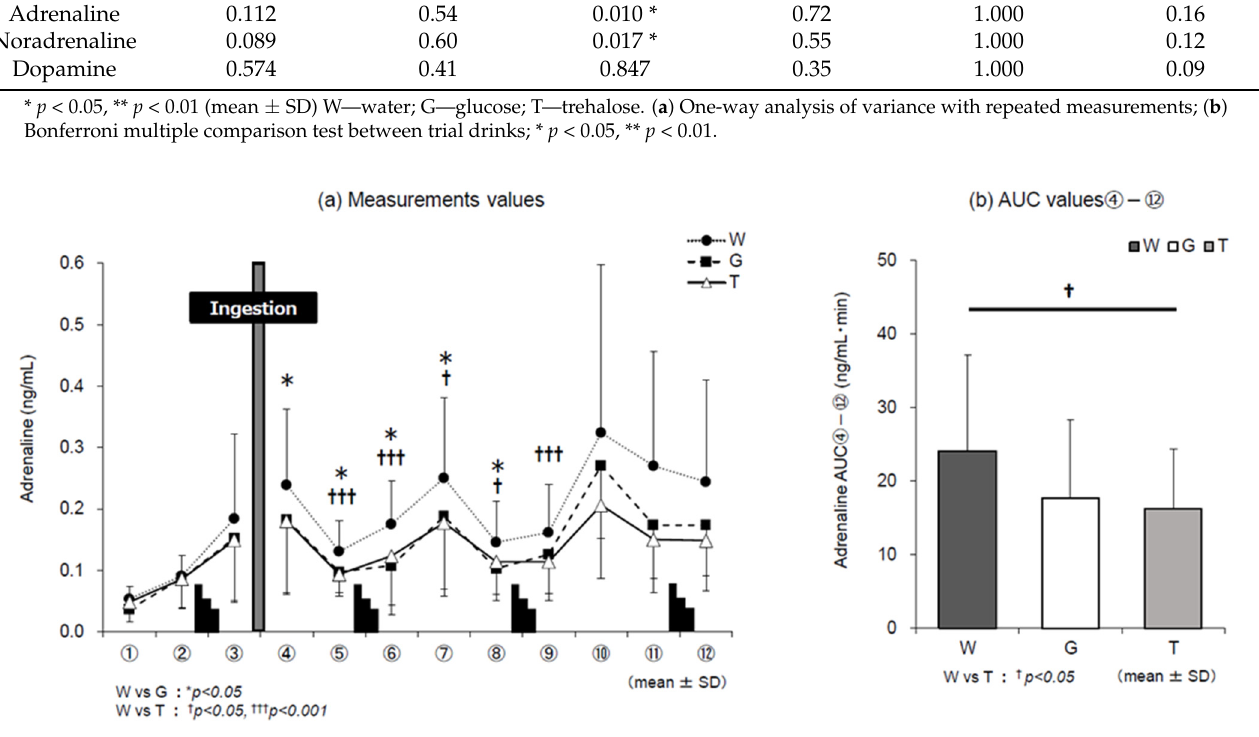
Figure 7. Changes in adrenaline levels for each trial. W—water; G—glucose; T—trehalose. Changes in adrenaline levels in each trial (water (W), glucose (G), trehalose (T)). Comparison between ( a ) measurements and ( b ) area under the curve